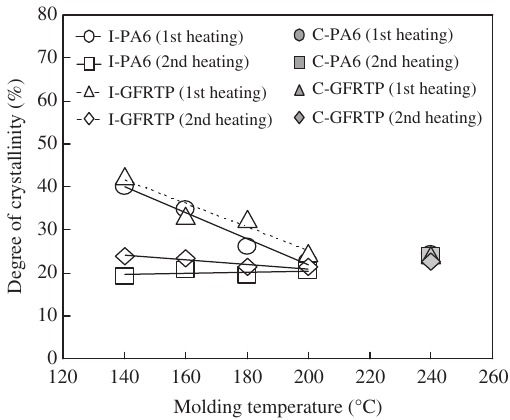
Figure 5 Effect of molding temperature on the degree of crystallin- ity for the first and second heating for I-PA6 and I-GFRTP.